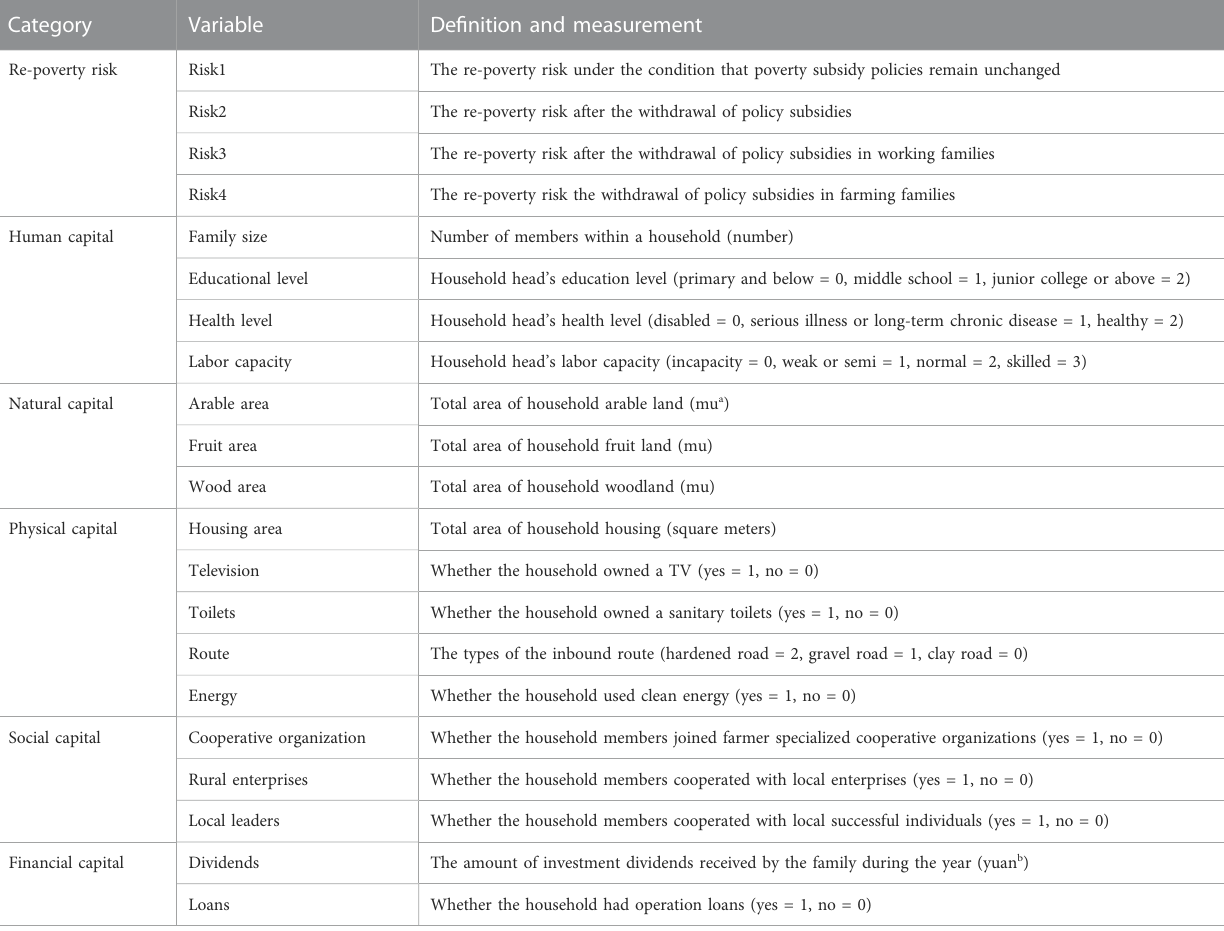
TABLE 1 De fi nition and measurement of re-poverty risk and livhood capital.